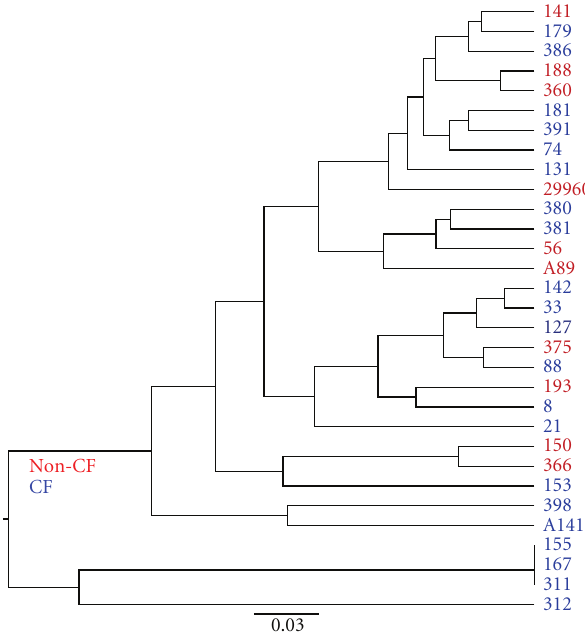
Figure 3: Unweighted pair group method with arithmetic mean (UPGMA) tree inferred using UniFrac distances. Red and blue names indicate bronchiectasis and CF,